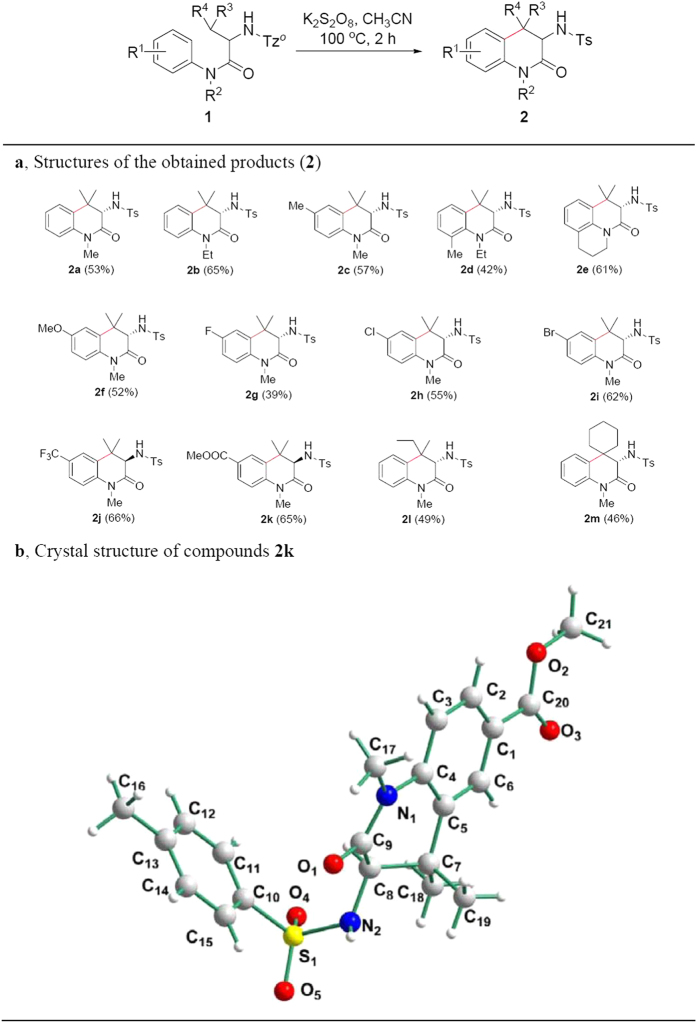
Substrate scope for couplings of aliphatic tertiary C-H and aromatic C-H bonds.(a) Structures of the obtained products (2). (b) Crystal structure of compounds 2k. Reaction condition: under nitrogen atmosphere, 1 (0.1 mmol), K2S2O8 (0.2 mmol), CH3CN (2.0 mL), reaction temperature (100 °C), reaction time (2 h) in a sealed Schlenk tube. *Isolated yield.